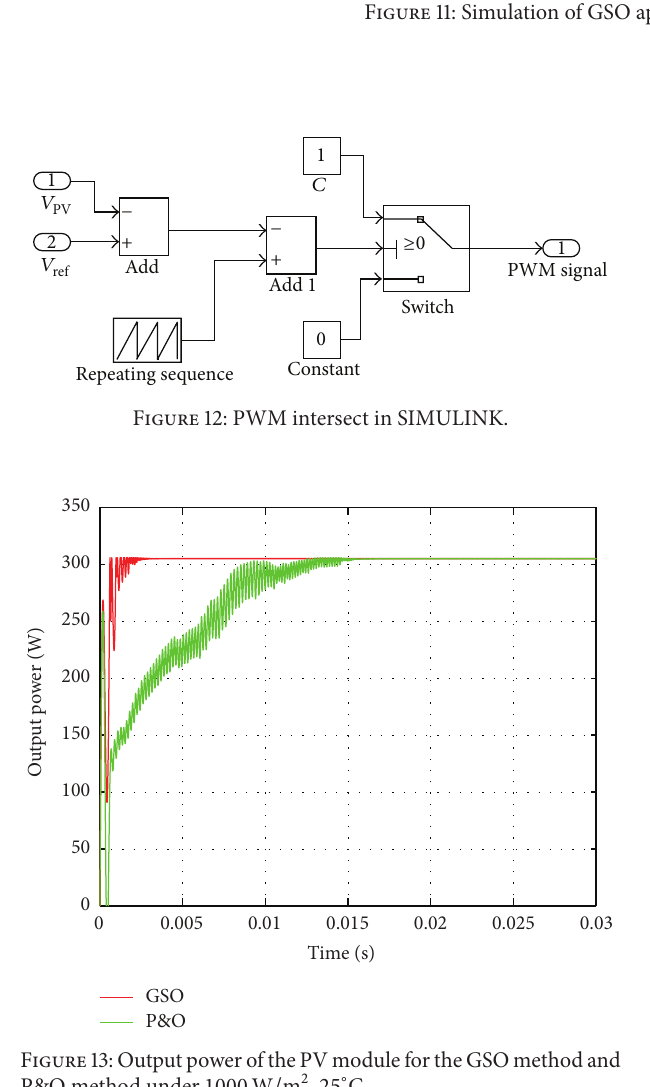
Figure 11: Simulation of GSO approach for the considered PV.